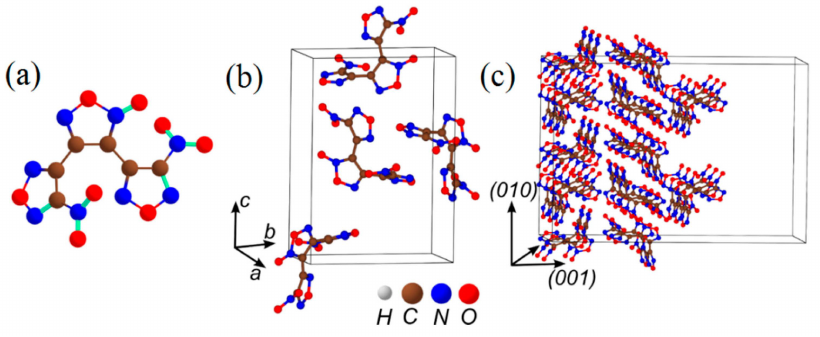
Figure 14. The structure of ( a ) a BNFF molecule; ( b ) a BNFF ideal crystal, and ( c ) a model supercell fragment of the (001) surface.